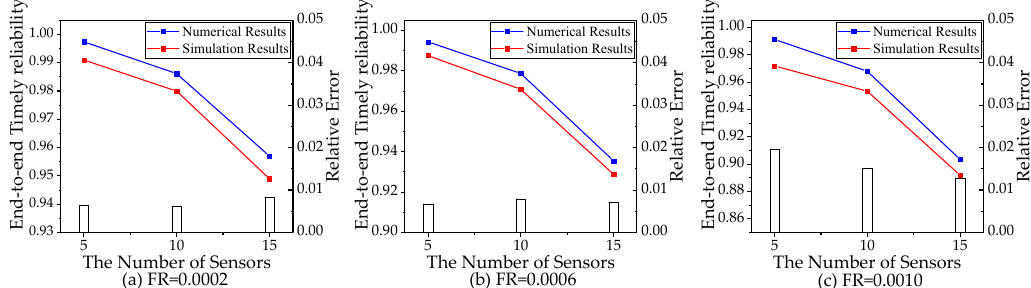
Figure 10. Numerical results and simulation results with failure rate (FR) equals ( a ) 0.0002, ( b ) 0.0006, and ( c ) 0.0010.